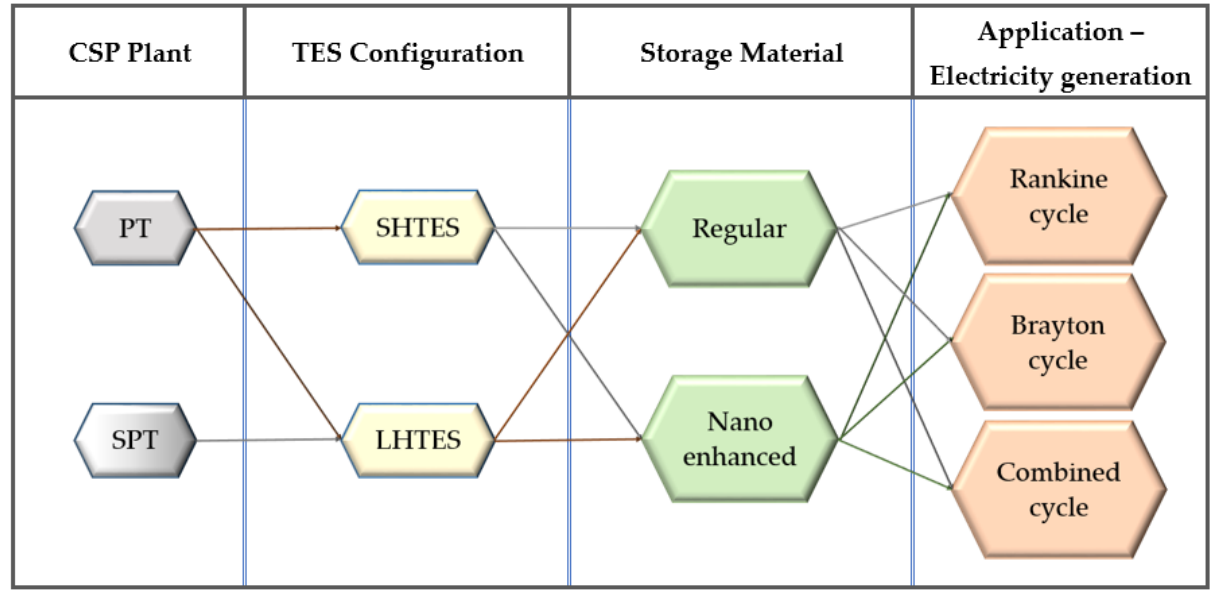
Figure 4. Scenario development for LCOE evaluation.